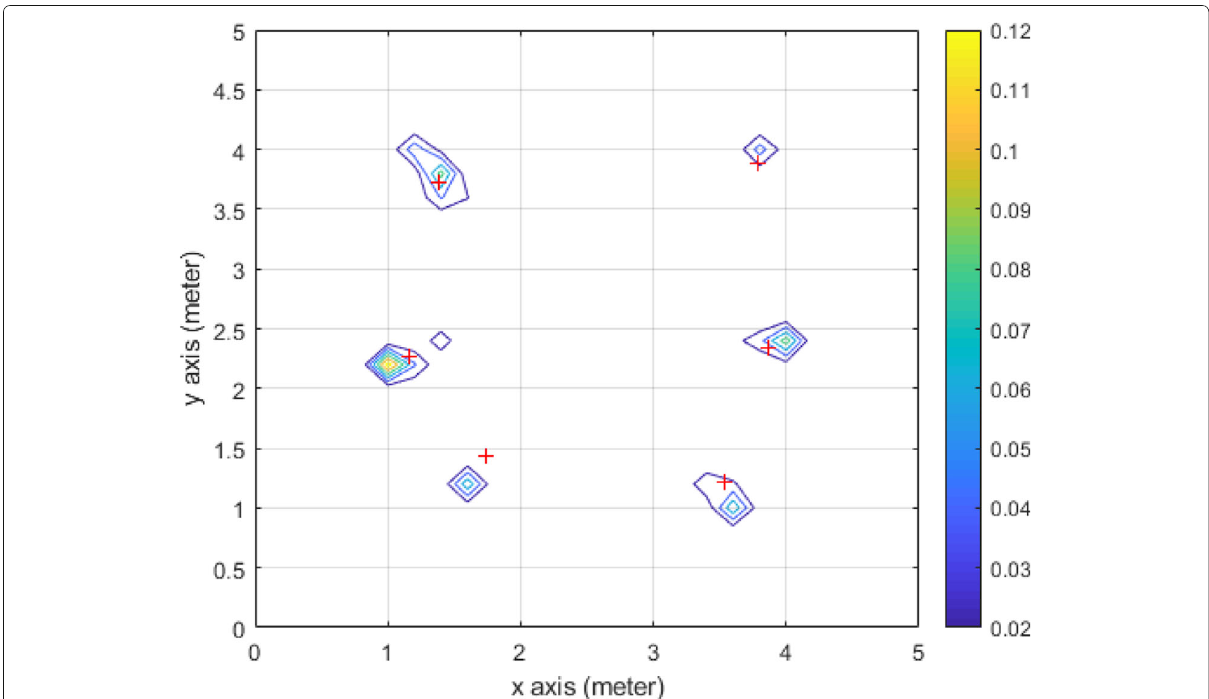
Fig. 9 The localization heat map LACES result. The final speaker positions are also added for evaluation